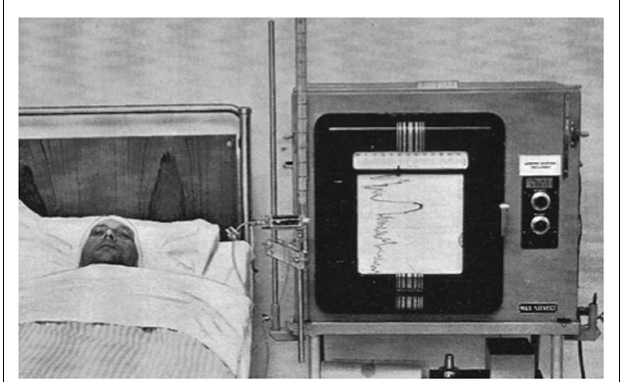
FIGURE 12 | Image from Lundberg’s 1960 publication on Continuous recording and control of ventricular fluid pressure in neurosurgical practice (8)